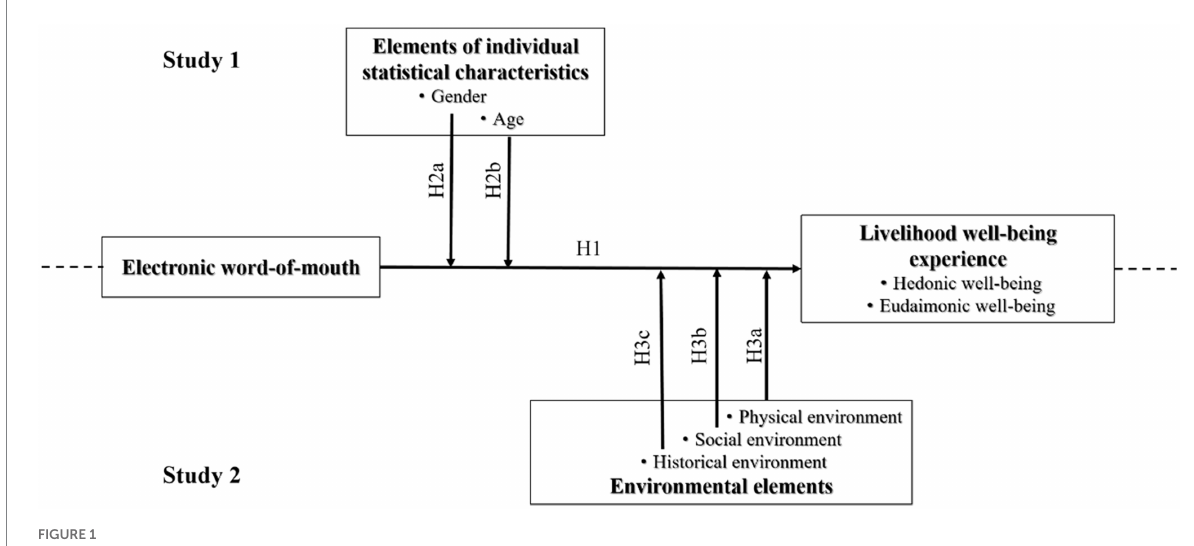
FIGURE 1 Theoretical model